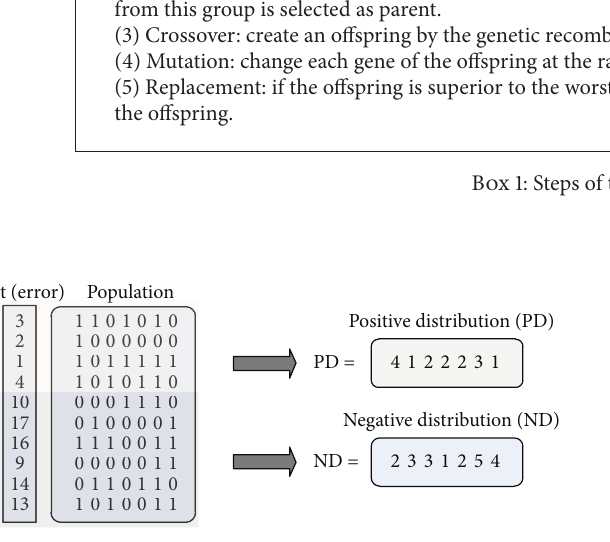
Figure 7: The feature distribution factors [25, 26].